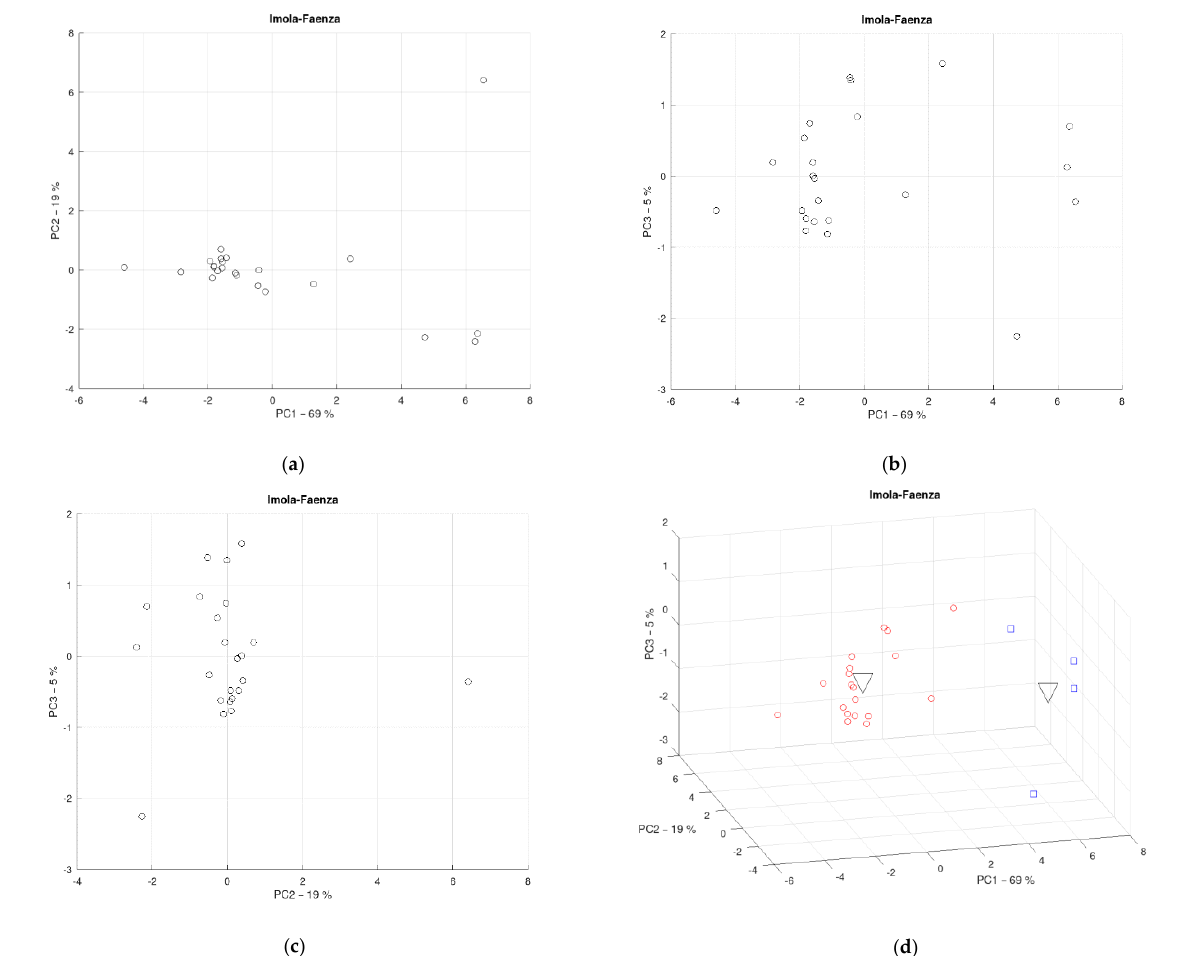
Figure 8. District of Imola-Faenza 2D-Score plot showing PC1 vs. PC2 ( a ), PC1 vs. PC3 ( b ), PC2 vs. PC3 ( c ), and 3D-score plot of the three principal components and clusters: first cluster in red and the second cluster in blue ( d ).